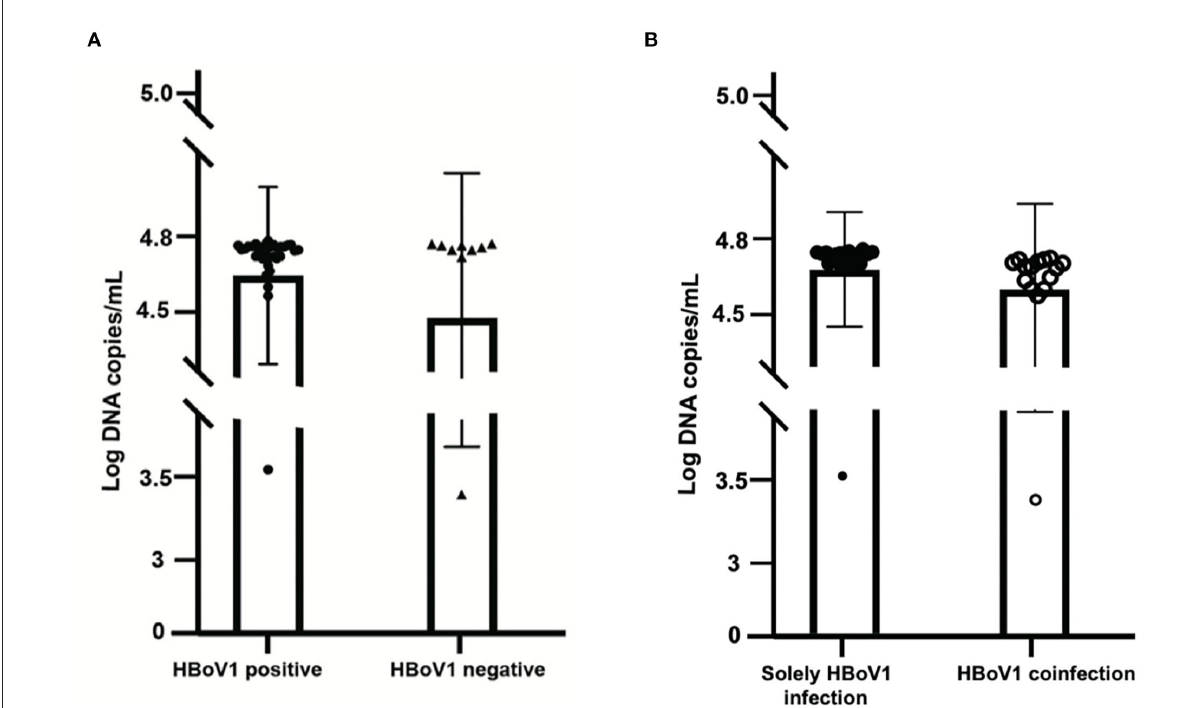
FIGURE3 Comparison of the viral load of 37 specimens positive for the HBoV1 antigen in black spots with 10 specimens negative for HBoV1 antigen in black triangles (A) . The comparison of viral load in HBoV1 positive antigen in black spots with negative antigen specimens from pediatric patients with acute respiratory infection in black circles (B)